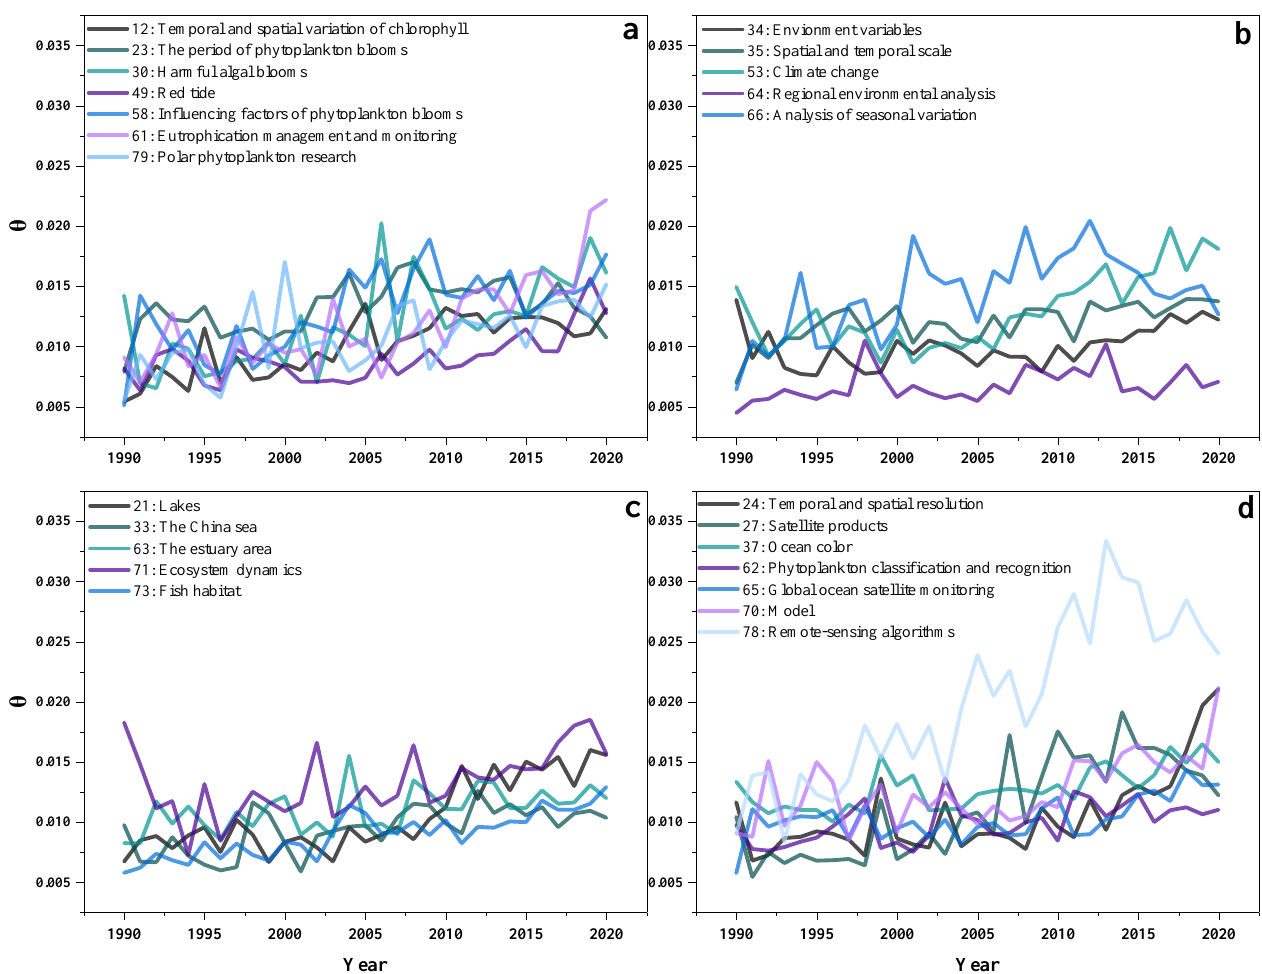
Figure 8. Hot theme tendency: ( a ) the subject of “algal (chlorophyll) changes,” ( b ) the subject of “temporal–spatial and environmental factors,” ( c ) the subject of “biological and geographic factors,” and ( d ) the subject of “remote sensing and methods.” The figure only shows topics with a significant linear increase.